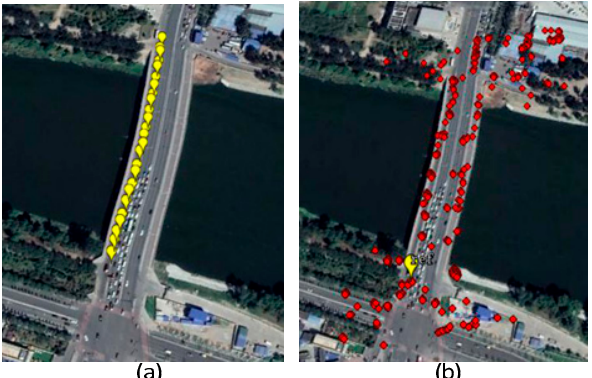
Figure 5. ( a ) The leveling points (yellow dots) and ( b ) the PS points (red dots) and the reference point (the yellow dot) on Google Earth.